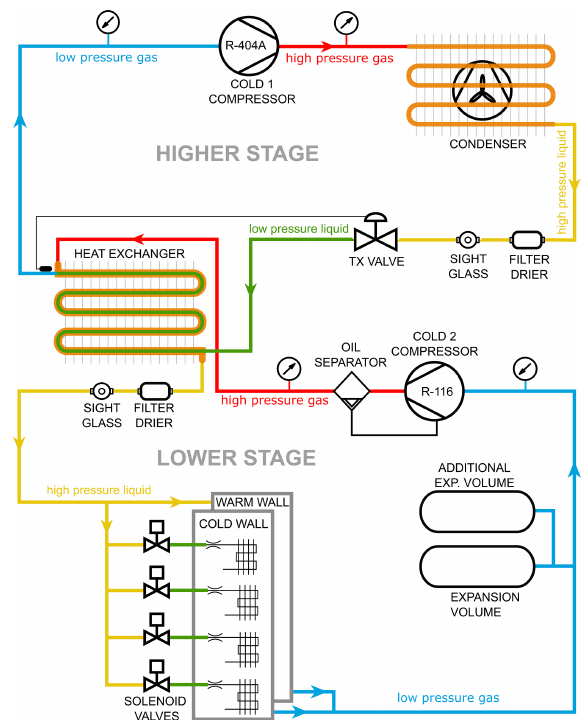
Figure 2. Diagram of the two-stage cascade compressor setup. Di- rection of refrigerant circulation is indicated by arrows. Pressure and phase state of the refrigerant are indicated by line colours. For the low-temperature SPIN modification, R116 from the lower stage is used to cool both wall plates, and an additional expansion volume is